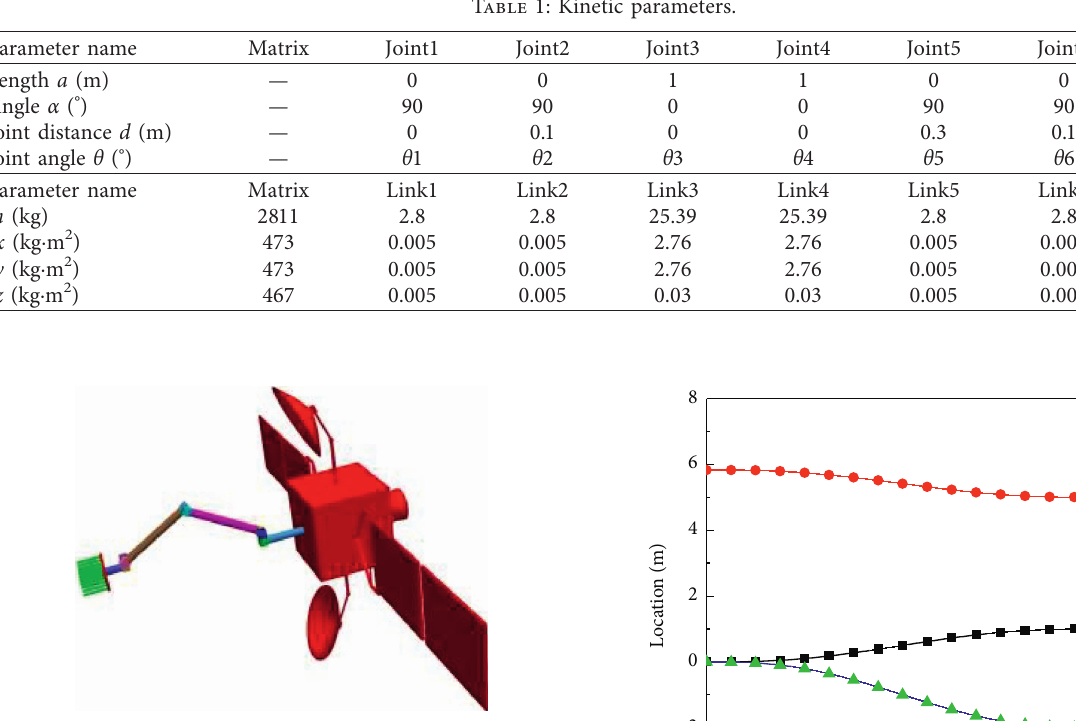
Figure 2: Space debris detumbling chaser.